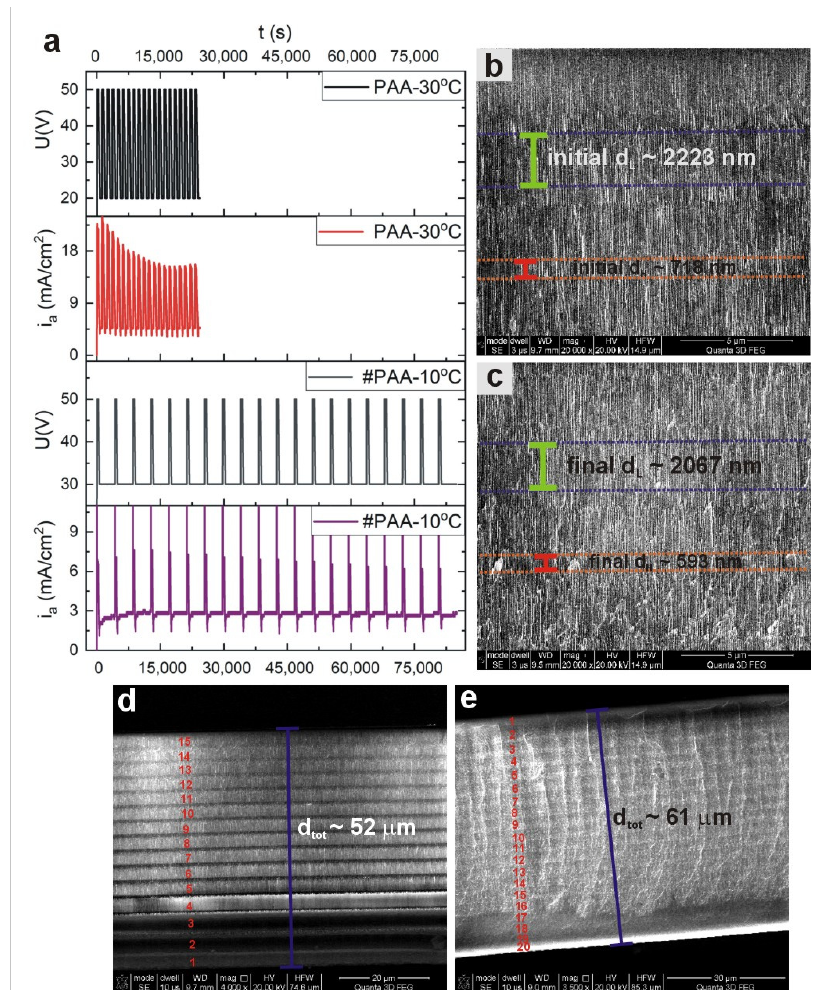
Figure 4. i a ( t ) curves recorded during pulse anodization (20 cycles) of the sample PAA—30 °C (U H = 50 V with t H = 360 s, U L = 20 V with t L = 480 s. at 30 °C) and #PAA—10 °C (U H = 50 V with t H = 360 s, U L = 30 V with t L = 3600 s. at 10 °C) ( a ); SEM images of initial ( b ) and final ( c ) d H and d L segments in the sample #PAA—10 °C; SEM image of a cross-sectional view of the whole PAA—30 °C ( d ) and #PAA—10 °C ( e ) membranes.